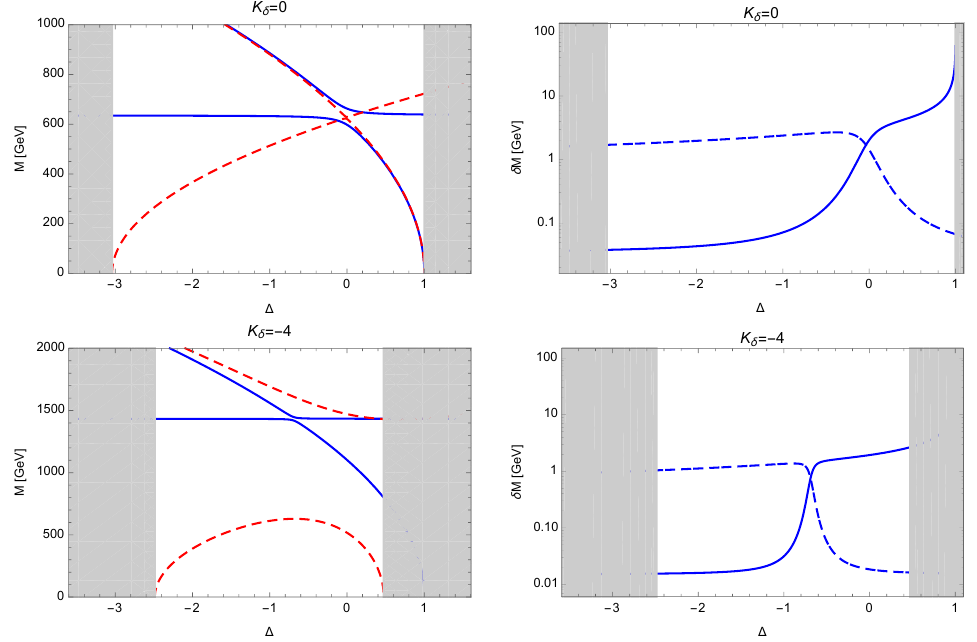
Figure 3 . (Left) Masses of the even (dashed red) and odd (blue) scalars as a function of (cid:1). (Right) Mass splitting between the charged and neutral scalars in the two odd tears, with the light one in solid lines. The two rows correspond to K (cid:14) = 0 : and (cid:0) 4 respectively. All values are in GeV, and we p (cid:12)xed C g = 1 = 3 C t and (cid:18) = 0 : 2 (i.e., 2 2 f = 1 : 2 TeV). The grey areas are theoretically unaccessible.